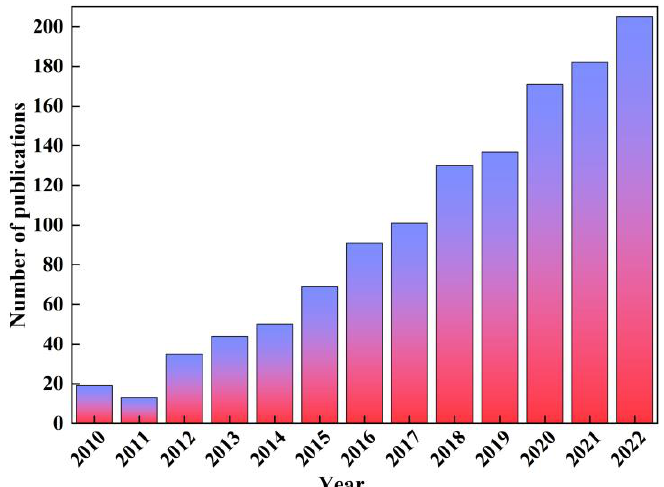
Figure 1. The number of research papers published on the application of CDI technology in water treatment from 2010 to 2022.